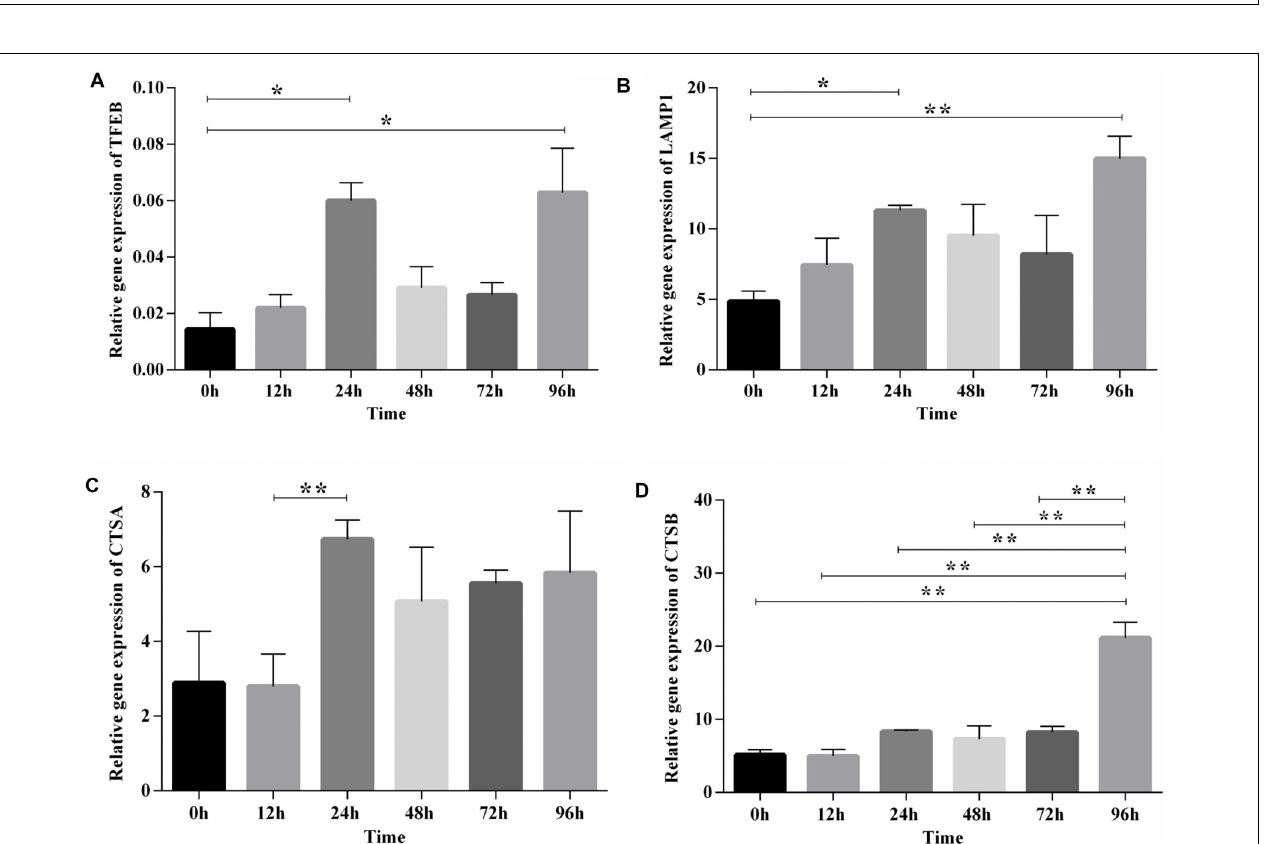
FIGURE 5 | The expression and significance test of TFEB and its downstream genes during induced differentiation of ICP1 preadipocyte line. (A) TFEB. (B) LAMP1. (C) CTSA. (D) CTSB. Mean significance at * P < 0.05 and ** P < 0.01 levels.